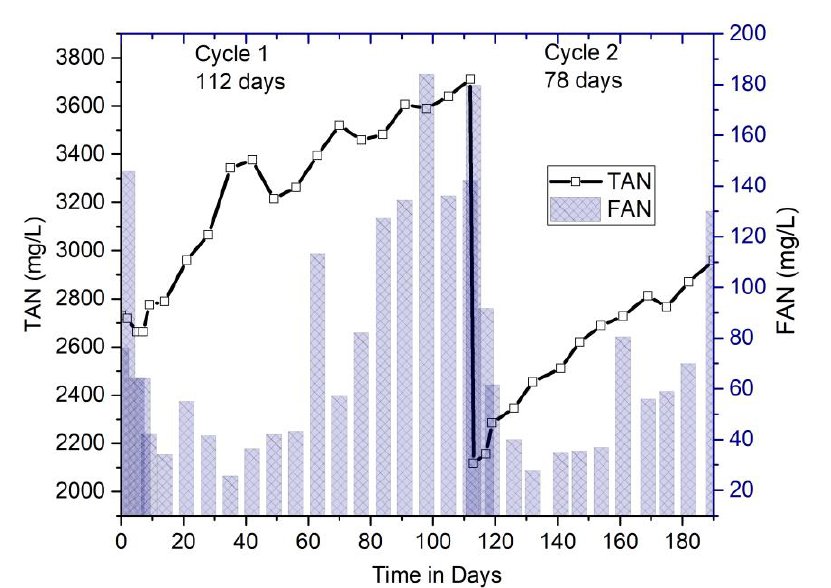
Figure 5. Evolution of total ammonia nitrogen (TAN) and free ammonia nitrogen (FAN) profiles.